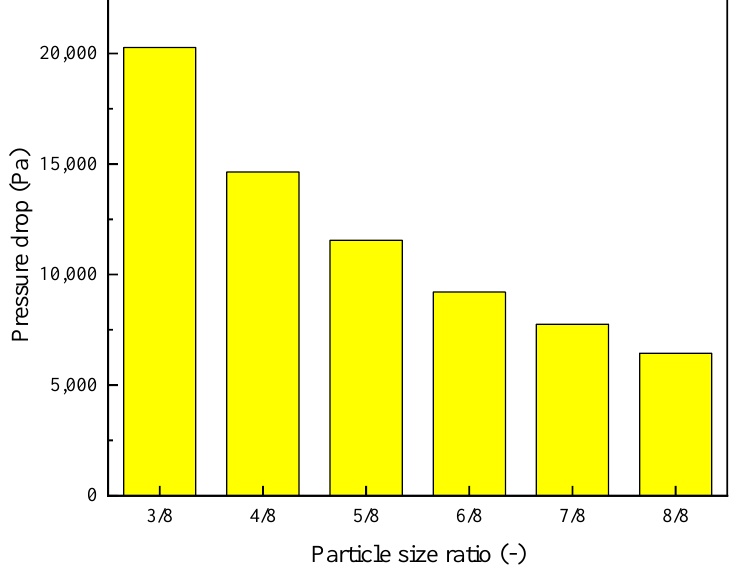
Figure 20. Pressure drop comparison with different particle size ratios.